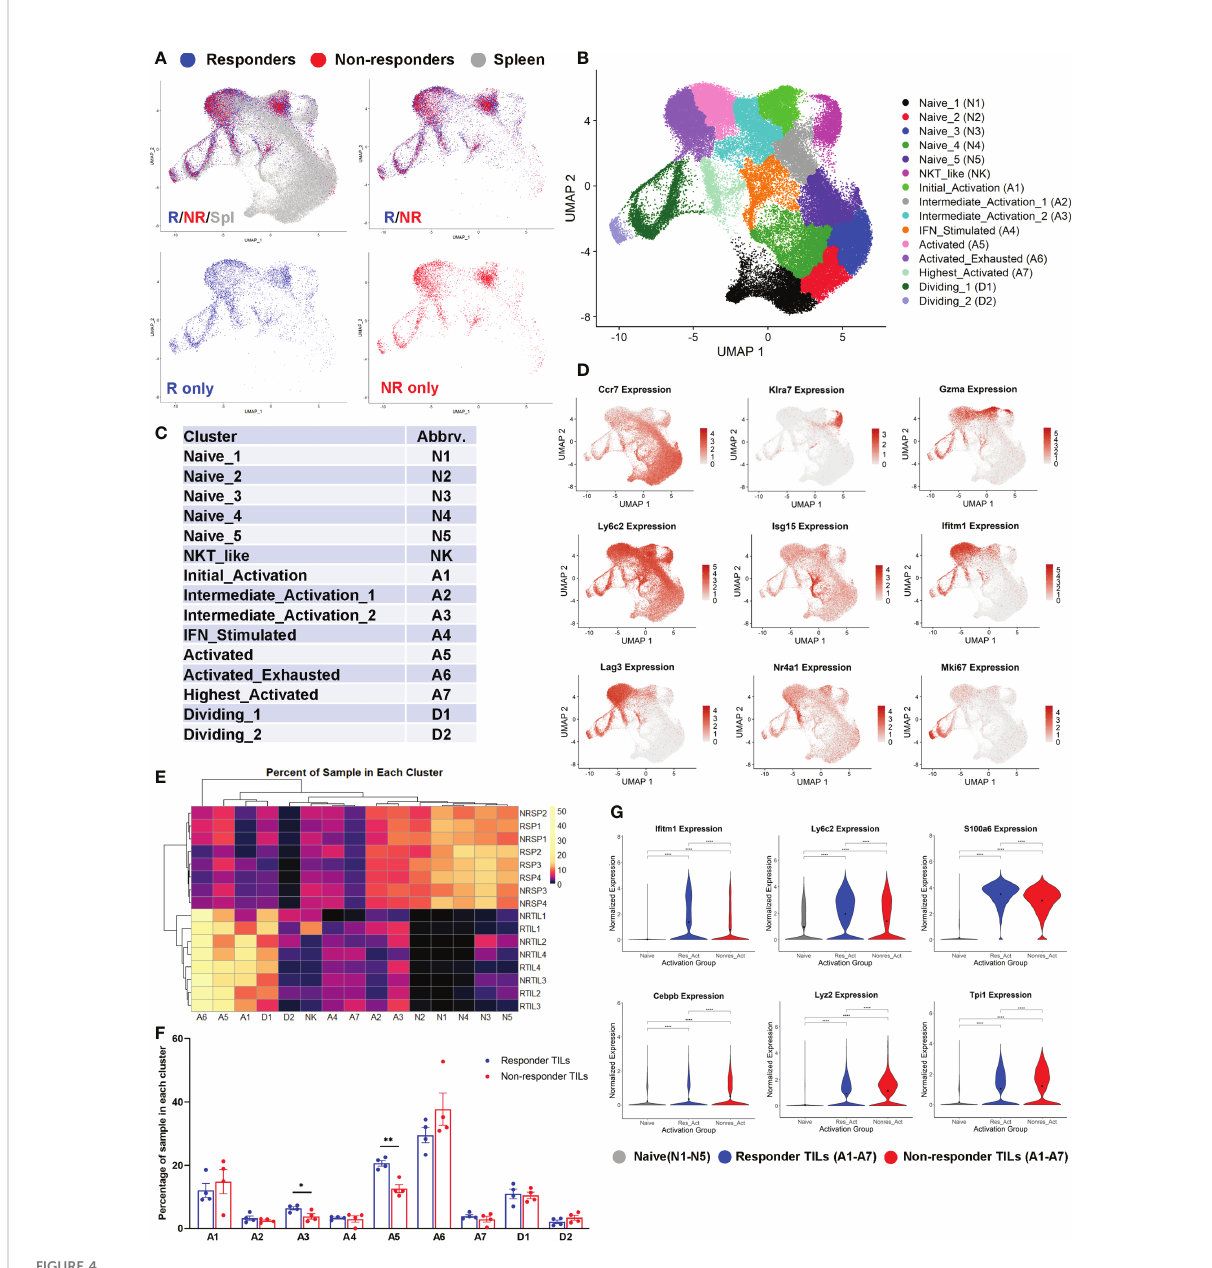
FIGURE 4 Both responder (R) and non-responder (NR) CD8 TILs were activated. (A) UMAP plots of different samples shown as superimposed for spleen (gray), R TILs (blue) and NR TILs (red) or superimposed for R TILs (blue) and NR TILs (red) or separately for R TILs (blue) and NR TILs (red). Gene expression data of total 74260 cells from all 16 samples (RSP1-4, NRSP1-4, RTIL1-4, NRTIL1-4) were analyzed using Seurat version 4.0.2 and clustered using UMAP (see details in Supplemental Table 1). (B) Cells from 16 different samples were clustered using UMAP and 15 different clusters were labeled based on gene expression. (C) Cluster abbreviations are listed to be referenced in other plots. (D) UMAPs showing the normalized expression of 9 genes representative of different clusters (gray=little to no expression; red=high expression). (E) Heatmap showing the percent of each sample residing in each cluster of the UMAP. Samples and cluster names were ordered by unsupervised clustering. (F) Graphical summary of the percent of R or NR CD8 TILs residing in each cluster of A1-A7 and D1-D2. Data were presented as mean ± SEM. Statistical signi fi cance was calculated with unpaired t test (*, P <0.05; **, P <0.01). (G) Violin plots showing the normalized expression of representative genes upregulated in R or NR activated TILs (residing in one of the 7 activated clusters: A1-A7) compared to naïve T cells (residing in N1-N5 clusters). Naïve; naïve clusters in all samples, Res_Act; activated clusters in R TIL samples, Nonres_Act; activated clusters in NR TIL samples. Black dot indicates the mean of each group. Different groups were compared using one-way ANOVA followed by Tukey ’ s multiple comparisons test (****, P